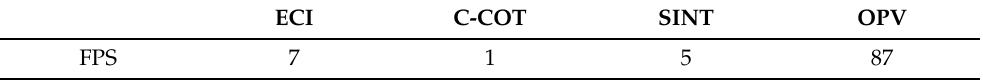
Table 5. Computational costs of OPV in terms of frames per seconds (FPS). ECI